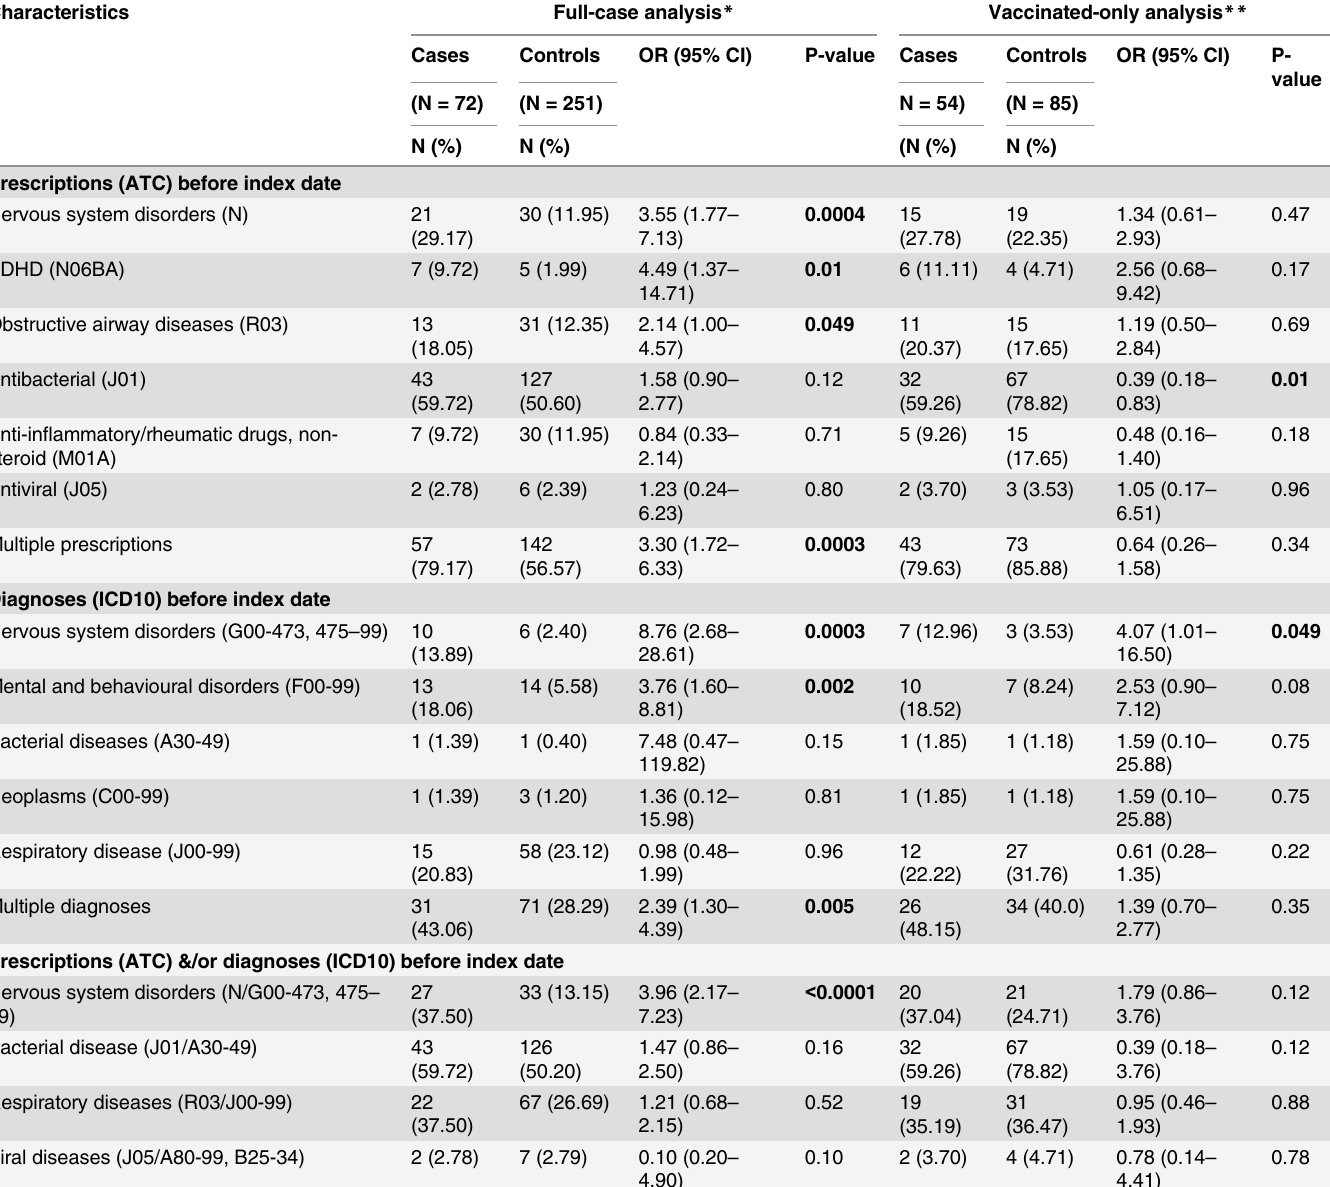
Table 2. Full case-analysis for prescription (ATC) history and diagnosis (ICD10) history before index date and vaccinated-only analysis for pre- scription and diagnosis history before index date on the risk of developing narcolepsy.